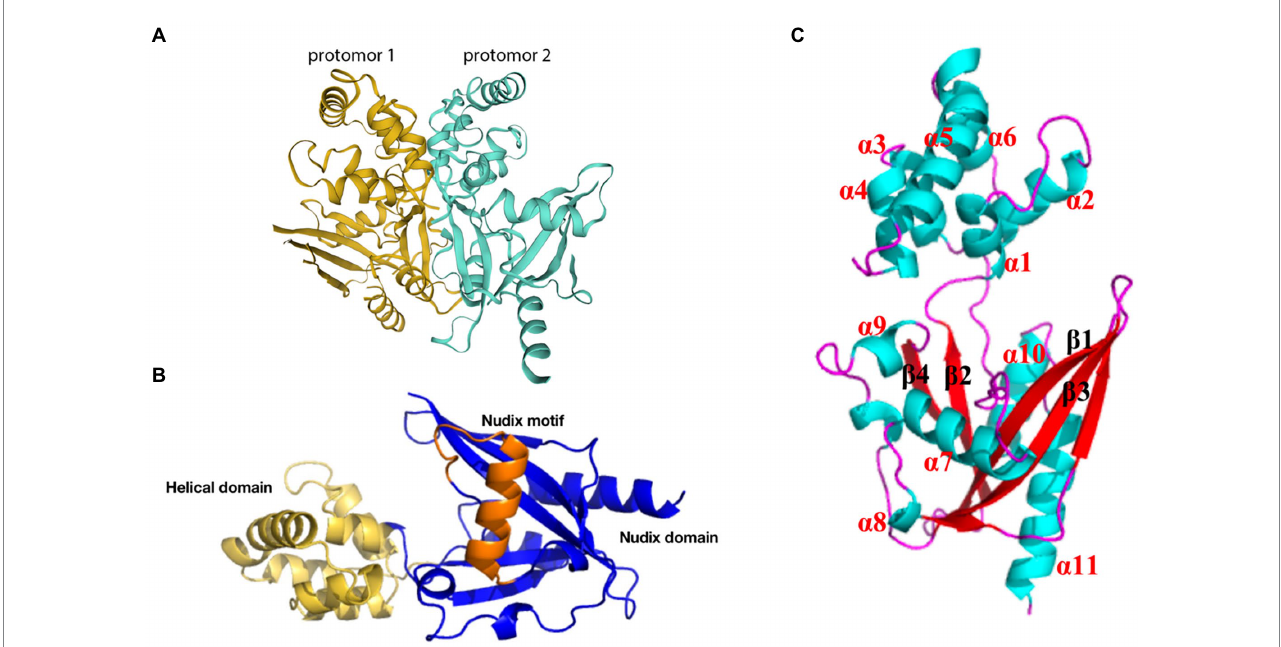
FIGURE 6 Schematic diagram of ASFV g5Rp structure. (A) g5Rp consists of two protomers “back to back,” protomer 1 is in dark yellow and protomer 2 is in cyan (Yang et al., 2022). (B) Nudix domain (dark blue), the helical domain (yellow), and the Nudix motif of g5Rp (orange). (C) The α -helices and β -sheets of the g5Rp